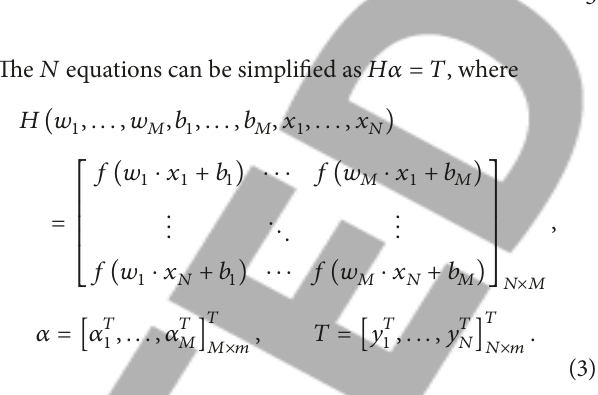
Figure 1: Architecture of the ELM (single layer